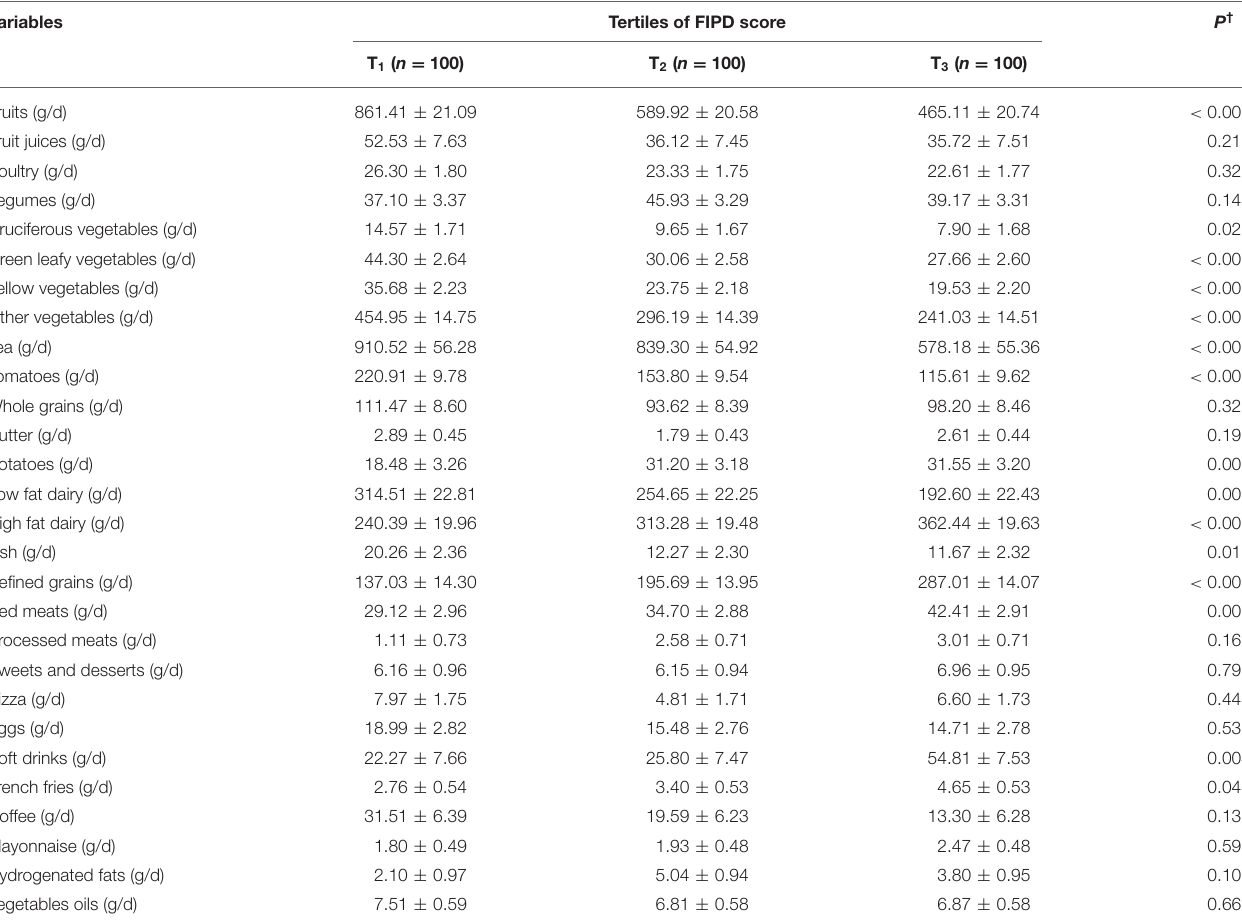
TABLE 2 | Dietary intakes of study participants by FIPD categories * .